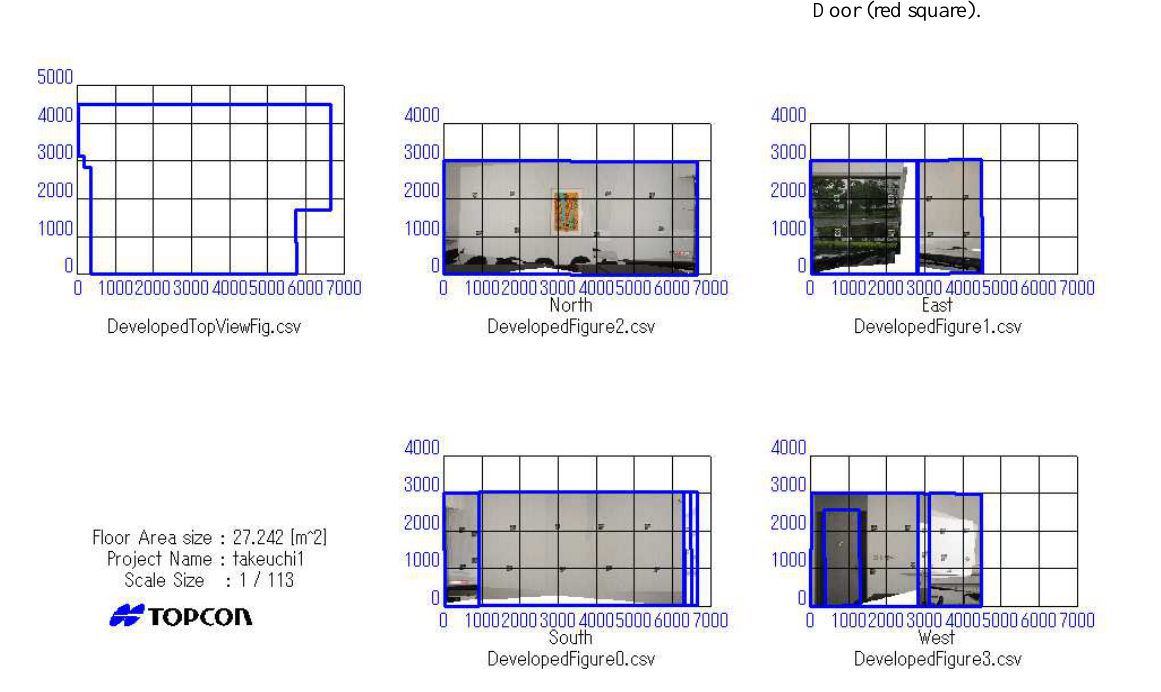
Figure 11. Development